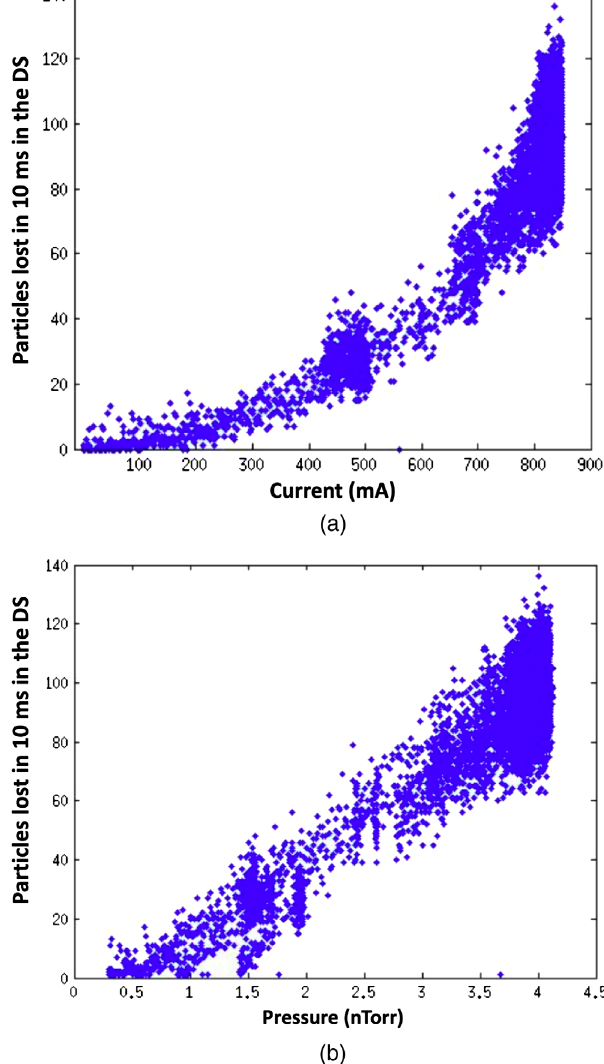
FIG. 15. (a) The measured loss rate in 10 ms in the sCVD in LER as a function of beam current and (b) as a function of vacuum